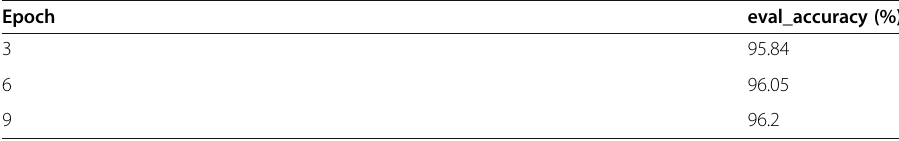
Table 1 Corresponding table of epoch and accuracy